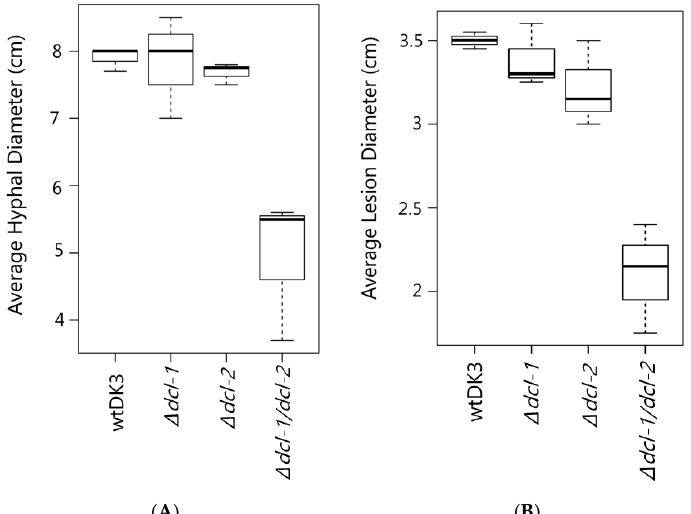
Figure 2. ( A ) Average mycelial growth of wild-type S. sclerotiorum and dicer gene disruption mutants grown on PDA for four days; and ( B ) lesion diameter measurements 72 hpi comparing wtDK3, ∆ dcl- 1 , ∆ dcl-2 and ∆ dcl-1/dcl-2 virus-free cultures inoculated on canola